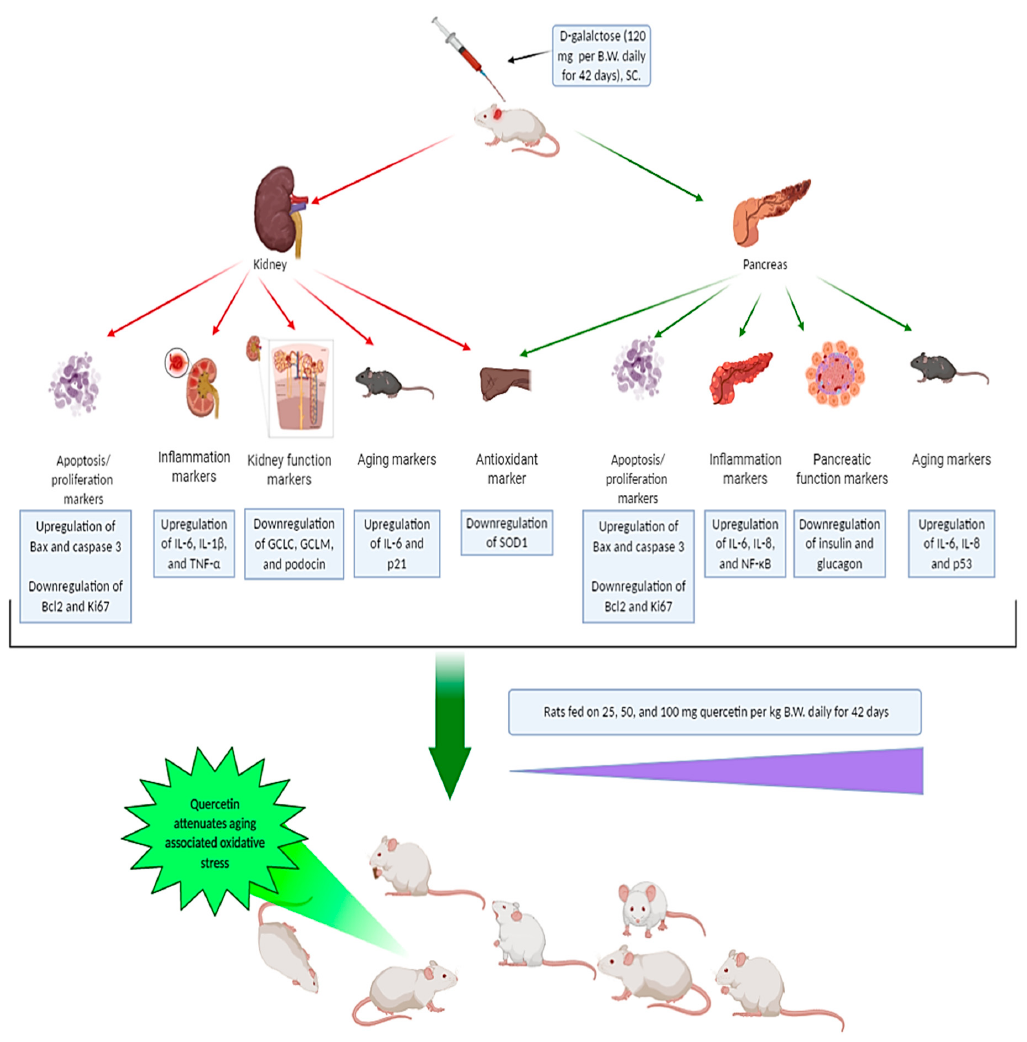
Figure 13. Summary of the protective e ff ects of quercetin against oxidative stress alterations associated with aging.